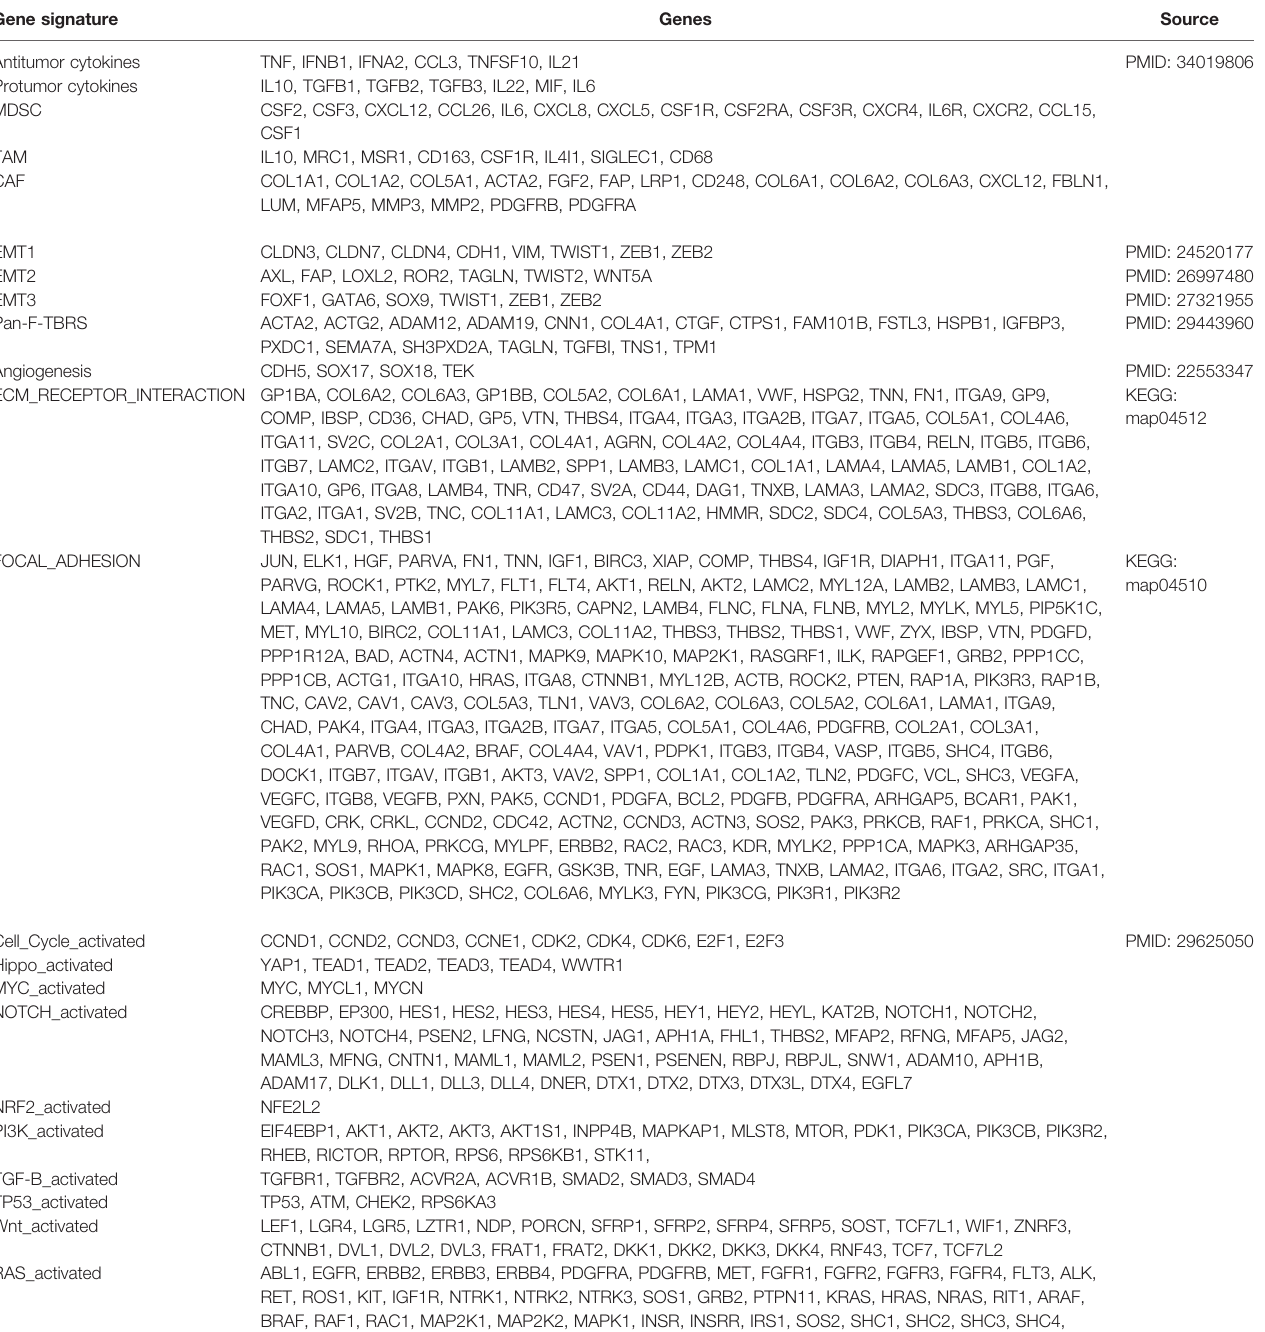
TABLE 5 | Gene signatures enrolled in this